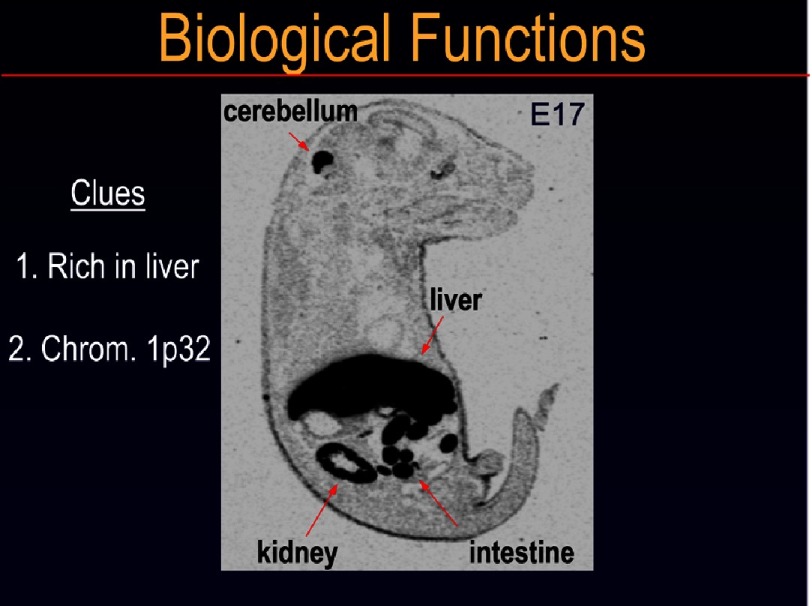
In situ hybridization histochemistry of the expression of PCSK9 mRNA in an embryonic day 17 (E17) mouse.Notice the high expression of PCSK9 in liver, small intestine, kidney and cerebellum. The locus of the human PCSK9 gene on the small arm of chromosome 1p32 is emphasized. This pattern of tissue expression of PCSK9 was the basis that led us to define its role in liver in cholesterol regulation.